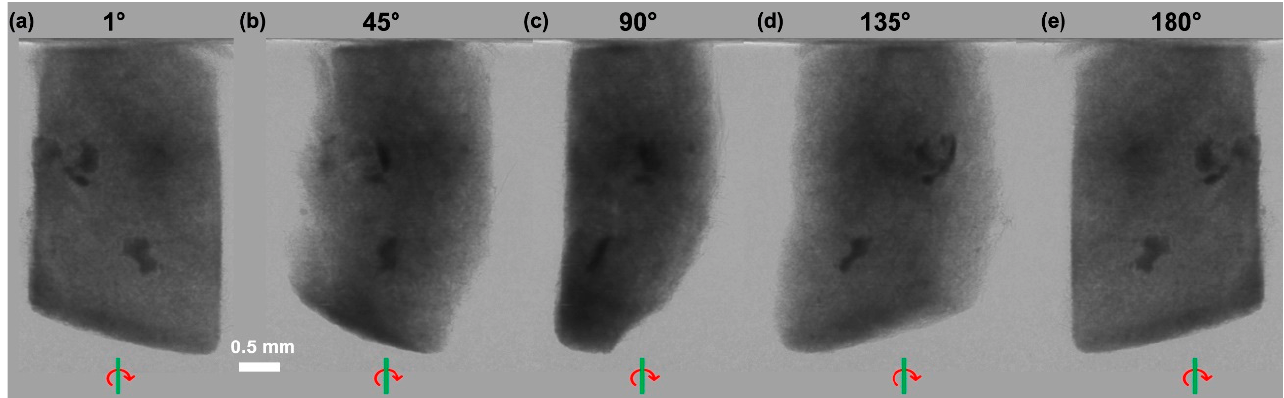
Figure 3. Tomographic projections at different tilt angles: (a)1°, (b) 45°, (c) 90°, (d) 135°, and (e) 180°. X-ray tomography is an ideal approach for imaging intact specimens without destroy- ing them owing to the long penetration depth of X-rays. Herein, the tomography of the yttria-stabilized ZrO 2 fiber insulation tile was performed, and the 3D virtual